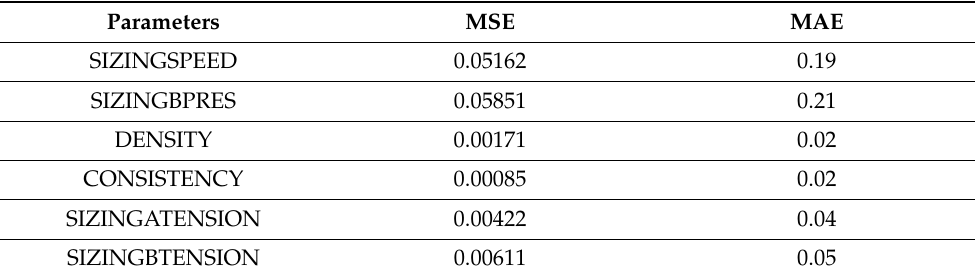
Table 11. Linear regression results for the sizing process.